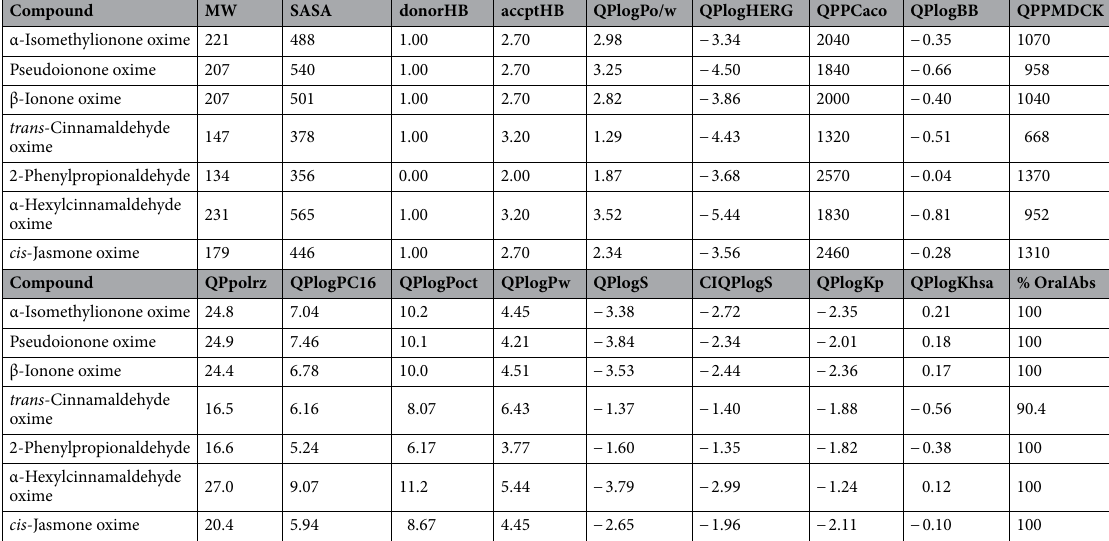
Table 1. Properties of ADME-Tox for the selected compounds with the lowest MIC. MW molecular weight, SASA total solvent-accessible surface area, donorHB estimated number of donated hydrogen bonds, accptHB estimated number of accepted hydrogen bonds, QPlogPo/w predicted octanol/water partition coefficient, QPpolrz predicted polarizability in cubic angstroms, QPlogPC16 predicted hexadecane/gas partition